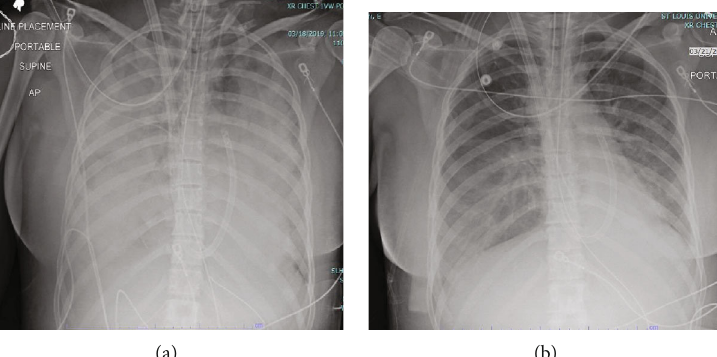
Figure 1: (a) Chest radiograph showed di ff use bilateral alveolar in fi ltrates on day 3 after the intoxication. (b) Chest radiograph showed signi fi cant improvement in bilateral in fi ltrates on day 5, right before the ECMO